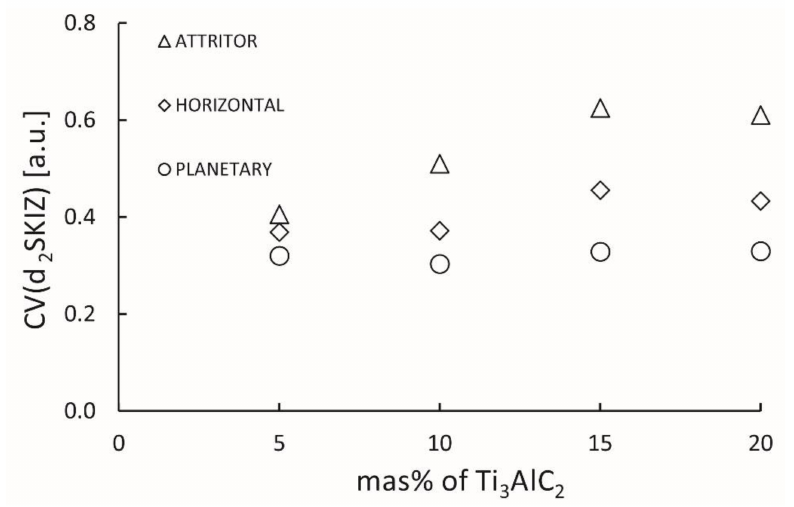
Figure 10. The CV SKIZ (coefficient of SKIZ variation) of homogeneity of the microstructure of obtained